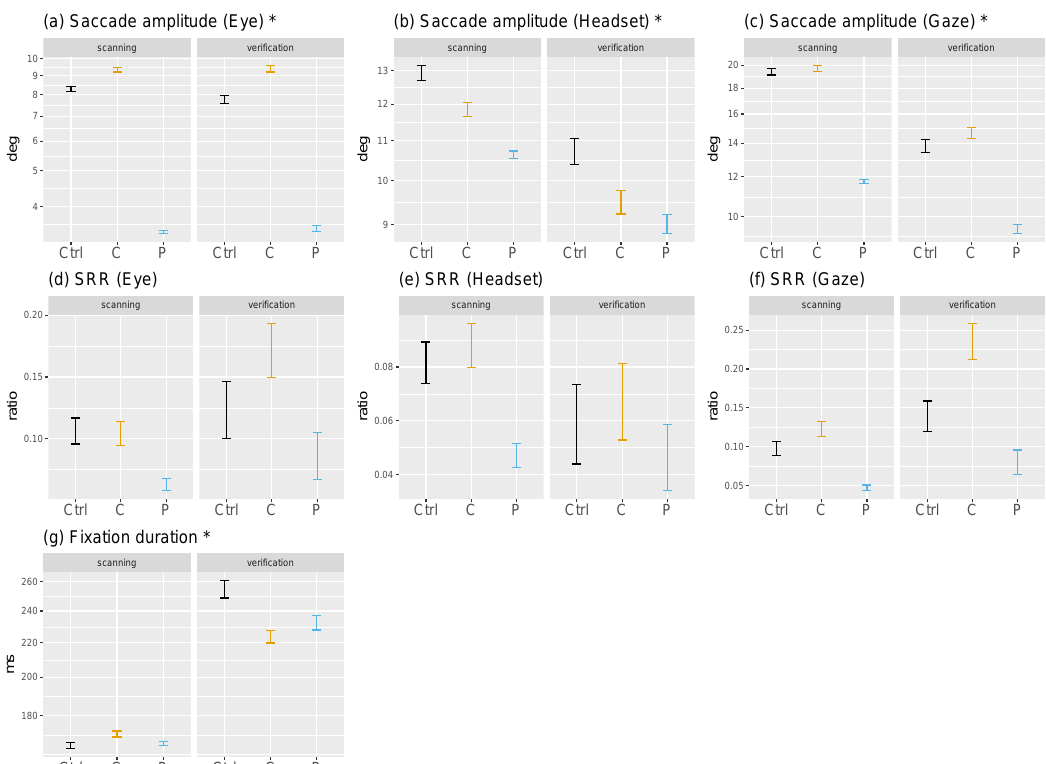
Figure 4. Visuo-motor variables are presented in this figure as a function of search phase (scanning and verification) and mask condition (control in black, central in orange and peripheral in blue) showing means and 95%CI. An asterisk to the right of a variable’s name indicates that it was log-transformed in linear mixed models and is presented on a log-scale here. SRR stands for saccadic reversal rate and measures the ratio of backward saccades produced precisely in the 170–190 deg.